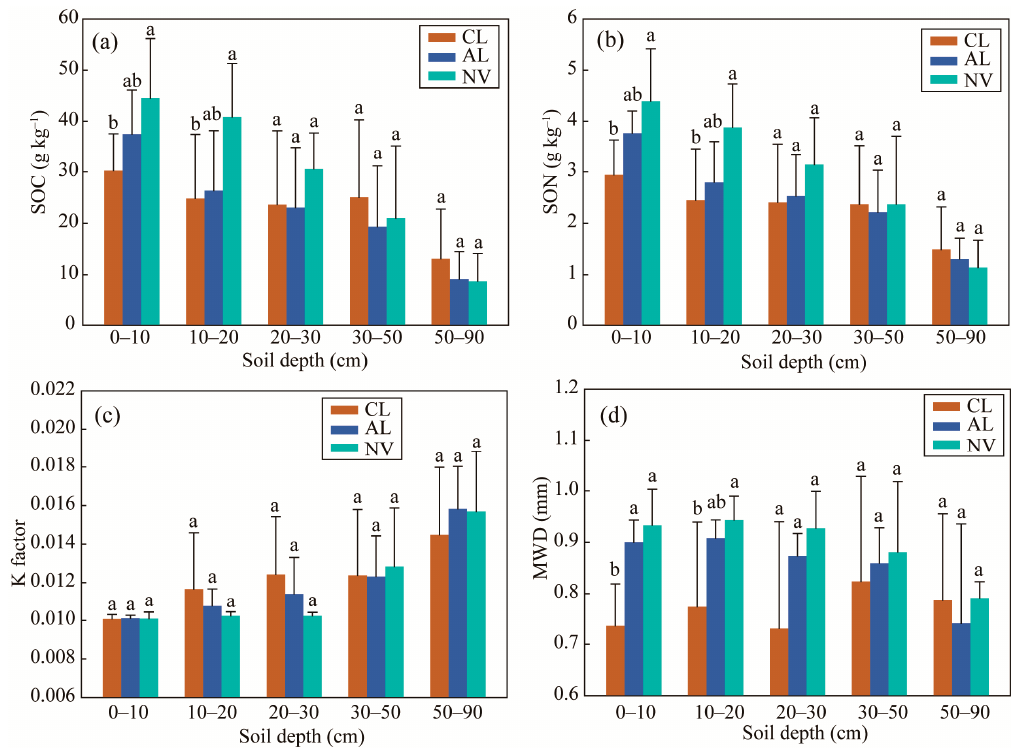
Figure 2. SOC content ( a ), SON content ( b ), K factor ( c ), and mean weight diameter (MWD) ( d ) in different depths of soil layer at different stages after agricultural abandonment. Lowercase letters indicate significant differences among the different stages after agricultural abandonment at p < 0.05 level on the basis of the least significant difference (LSD) test. NV, native vegetation land; AL, abandoned cropland; CL, cropland.